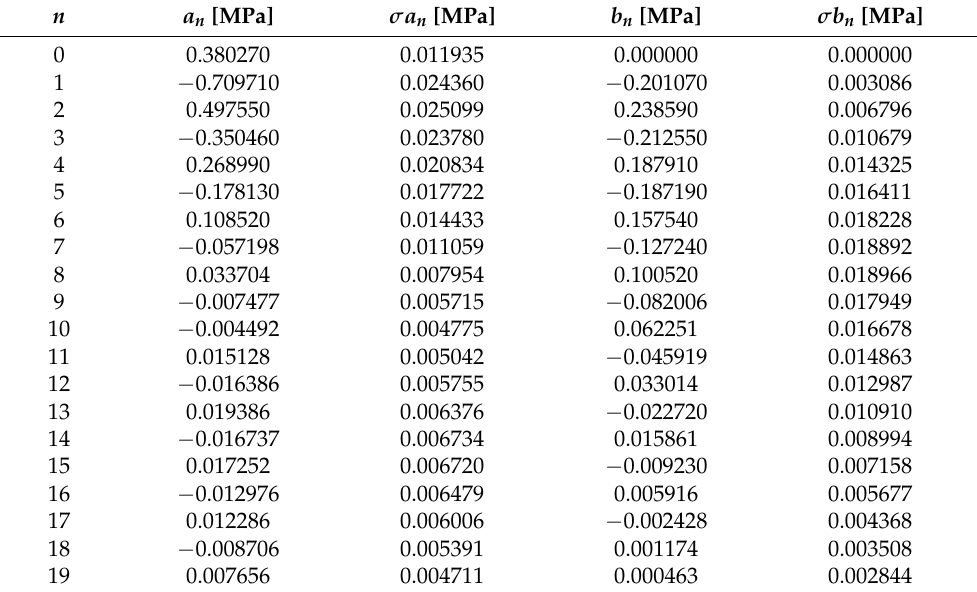
Table A1. The values of coefficients a n and b n and standard deviations σ a n and σ b n .